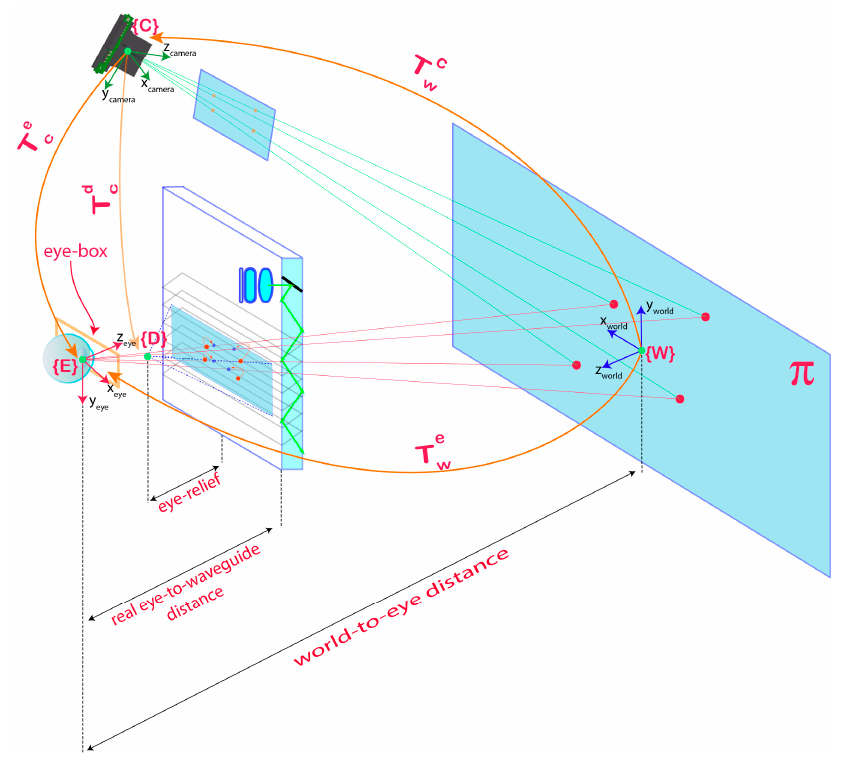
Figure 2. Geometry of the perspective preserving homography induced by a reference plane placed at a pre-defined distance from the eye.